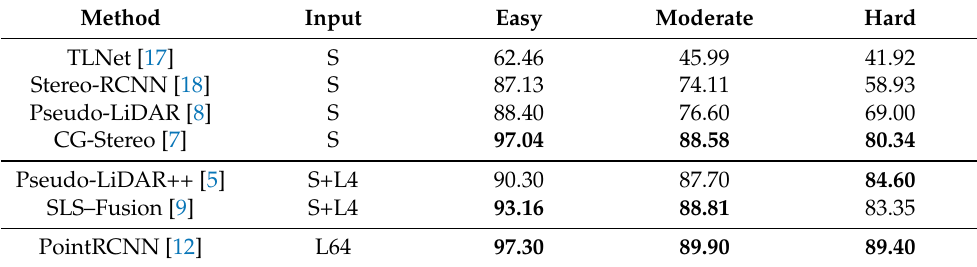
Table 1. Evaluation of the 3D object detection part of SLS–Fusion compared to other competitive methods. Average precision AP BEV [16] results on the KITTI validation set [13] for the “Car” category with the IoU at 0.5 and on three levels of difficulty, (defined as [14]): easy, moderate, and hard. S, L4, and L64, respectively, denote stereo, simulated 4-beam LiDAR, and 64-beam LiDAR. According to the inputs, the maximum average precision values are highlighted in